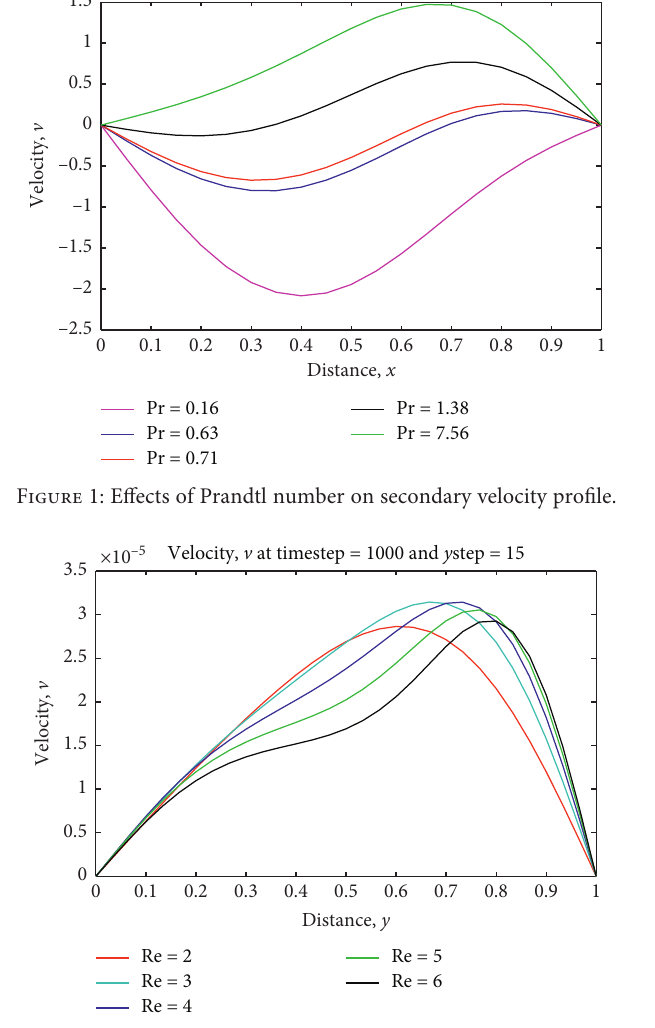
Figure 2: Effects of Reynolds number on secondary velocity profile. Velocity, u at timestep = 1000 and y step = 15